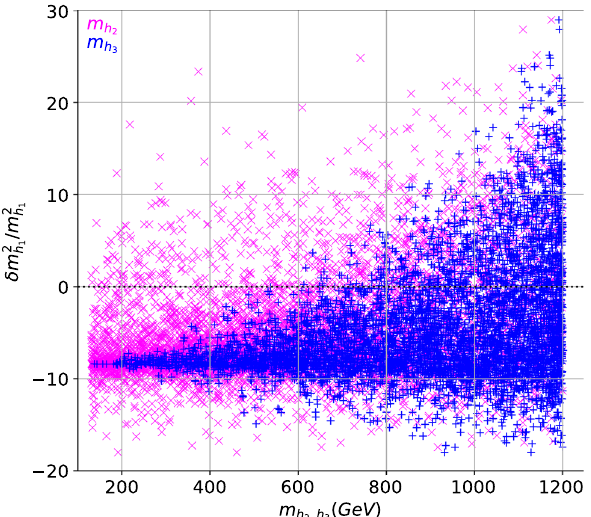
/ m 2 asafunctionoftheHiggsboson h 1 h 1